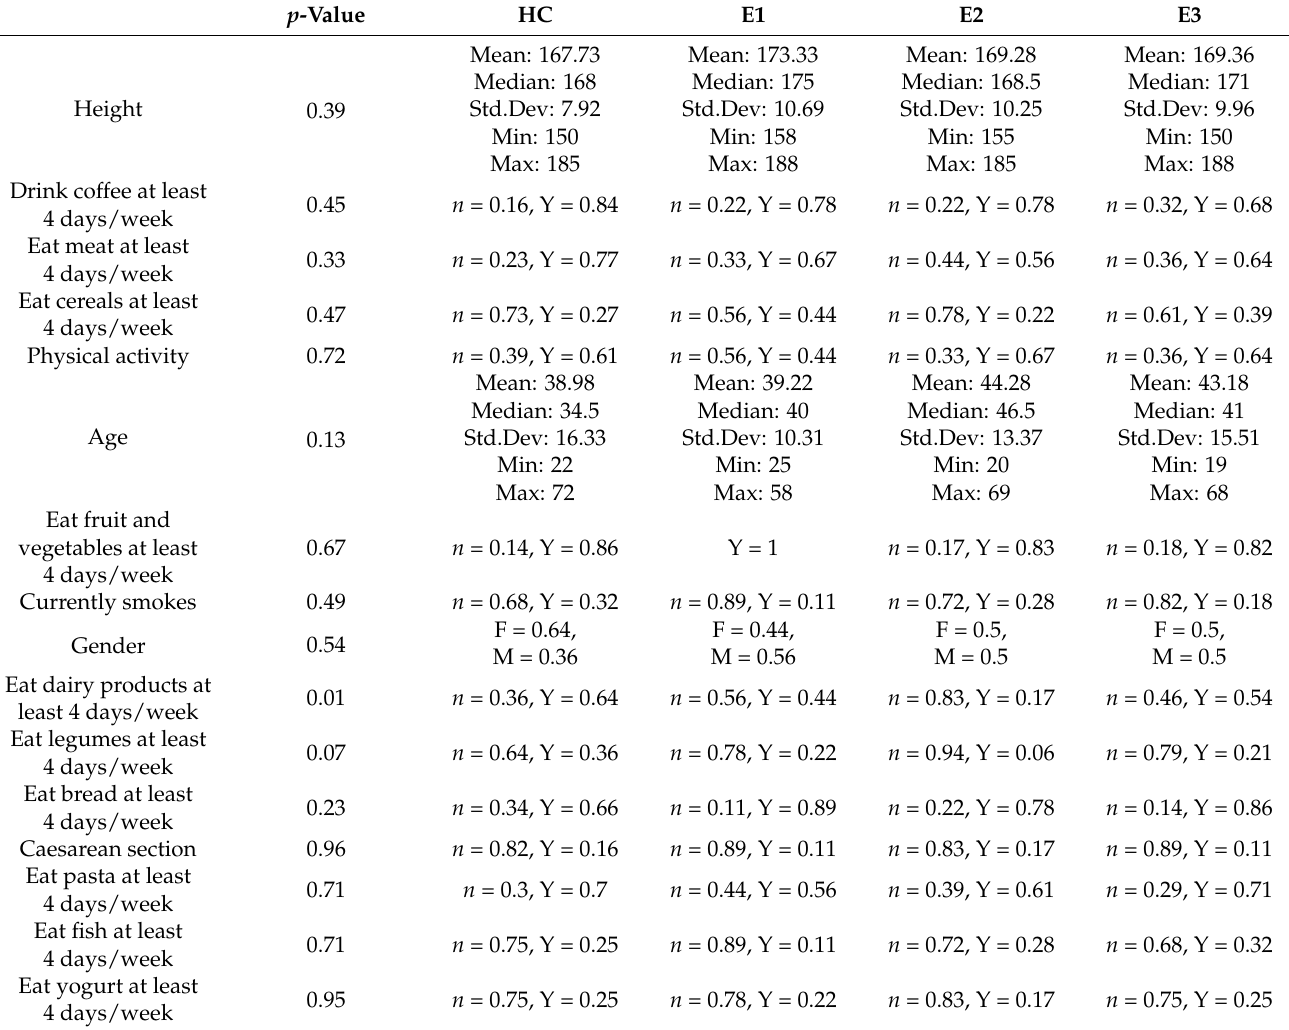
Table A2. Demographic and habits-related parameters of the cohort. The p -values refer to the Kruskall–Wallis test and Fisher’s test between the Montreal E scale and the numeric or categorical variables, respectively. n = no, Y = yes. The variable in bold was significantly unbalanced between